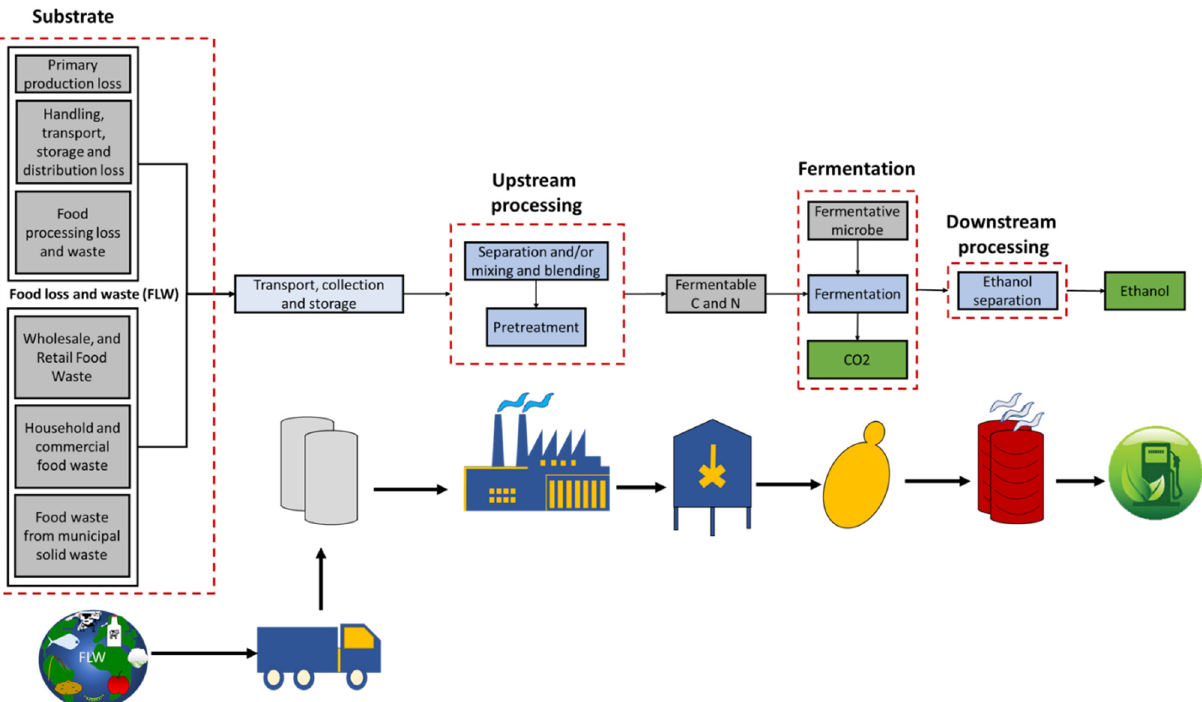
Figure 6. An overview of the bioethanol production process using FLW. The bioprocess operations start with the potential source separation, transport, collection and storage of the FLW at the production site. The FLW obtained is subjected to upstream processing to obtain the carbon and nitrogen required for the fermentation. The fermentation by an ethanologenic microbe produces ethanol in the broth which after downstream processing is separated from the broth to obtain bioethanol. Ethanol separation from the fermentation broth is not the only challenge faced for downstream processing. The presence of competing products and organic acids from the FLW and the fermentation broth can create challenges in economic separation of the eth- anol. In addition to that, the type of FLW used consisting of pectin can also pose challenges for the downstream processing, as pectin can be converted to methanol during fermenta- tion that can cause the separation challenges [189–191]. In the batch processes, the carbon source is usually utilized to exhaustion; however, in the fed-batch processes, the remain- ing amount of carbon source can interfere in the product separation. Silicalite, a zeolite- like structure mainly consisting of five-membered rings of silicon–oxygen tetrahedra, was shown to adsorb ethanol independent of ethanol broth concentration (2–8% w / v ) and tem- perature (30–60 °C) without any adsorption of glucose [182]. Such adsorption can ensure the carbon source is returned back to the bioreactors for further fermentation and prevent any inhibitor production during downstream distillation. 6. By-Products FLW is rich in carbohydrates and nitrogen. The by-products in the fermentation pro- cess depend on the substrate being used and the microorganism being used. Lignocellu- losic biomass has less nitrogen compared to FLW consisting of agricultural products fit for human and household use. Post-fermentation, an organic fertilizer grade material can be obtained from the solids. The solids (25% w / w ) obtained from the bioethanol plant us- ing sugarcane bagasse for ethanol production had 300 mg/L phosphorous and <1 mg/L nitrogen. When the fertilizer obtained from fermentation solids was applied to the snap bean as a phosphorus-rich fertilizer, the yield was 298 g/plot vs. 94 g/plot for phosphorous fertilizer and 51 g/plot for the control with no fertilizer [192]. The fermented broth also contains several organic acids viz. acetic acid, propanoic acid, butyric acid, etc. which can